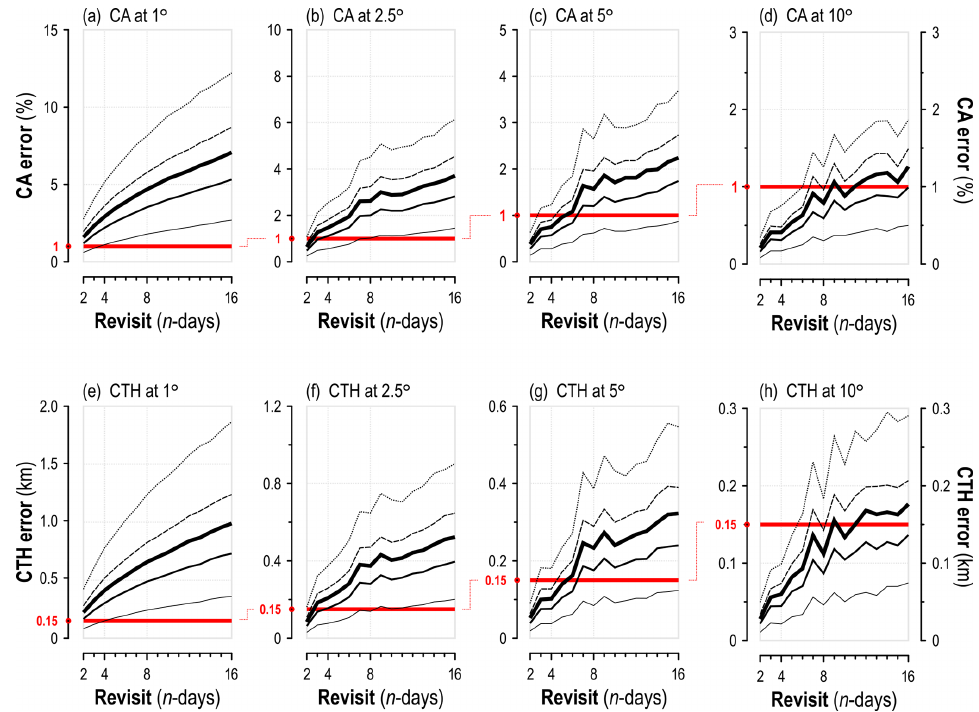
Figure 4. The spread of differences in cloud amount (a–d) and cloud top height (e–h) between 1d and n day revisit climatologies, with respect to n ranging from 1–16d. Data refer to the simulated 2.5 ◦ resolution CALIPSO dataset. Starting from the top-most, the lines indicate range covering: 99% of observations (dotted line), 95% (dashed line), 90% (bold solid line), 80% (regular solid line), and 50% (thin solid line). Red bar indicated location of the accuracy threshold (see text for details). 16d revisit can be achieved with one CALIPSO-like satellite, 8d with two, 4d with four, and 2d with eight (phased orbits assumed). Note that for clarity the vertical scale has been adjusted for each